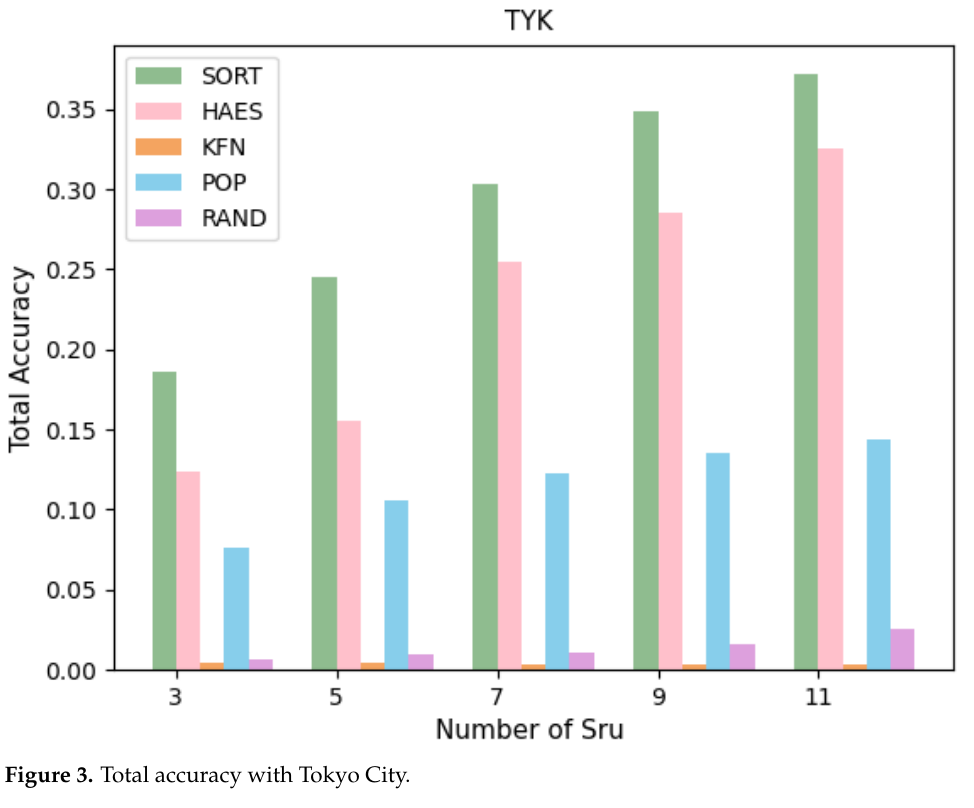
Figure 3. Total accuracy with Tokyo City.